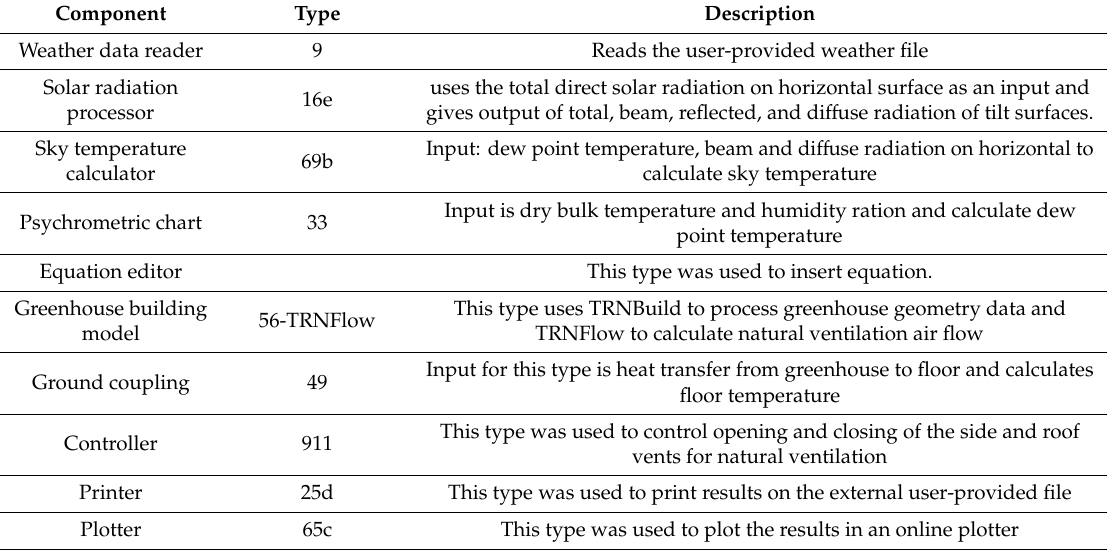
Table 5. Components of the greenhouse model in TRNSYS